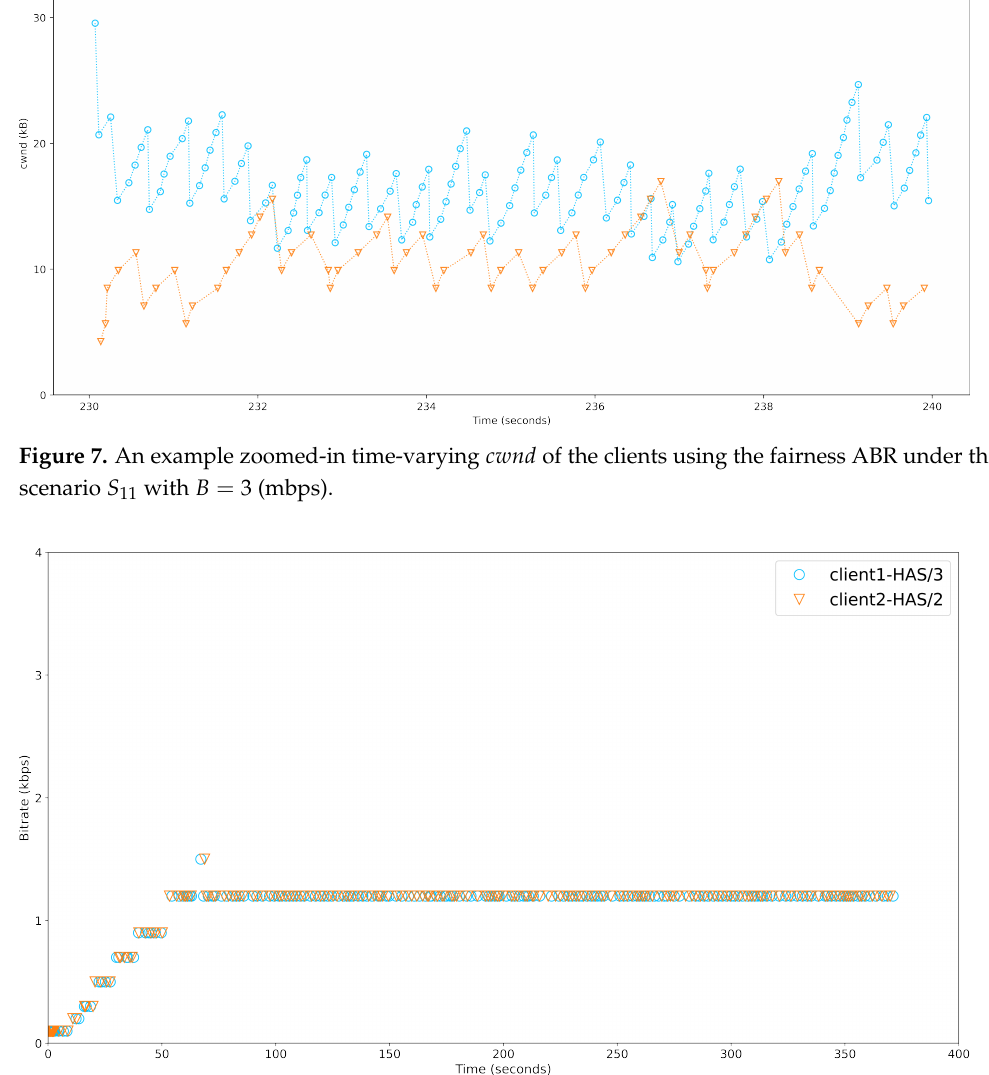
Figure 8. An example time-varying bitrate selection of the scenario S 11 with B = 3 (mbps) when applying a bandwidth allocation